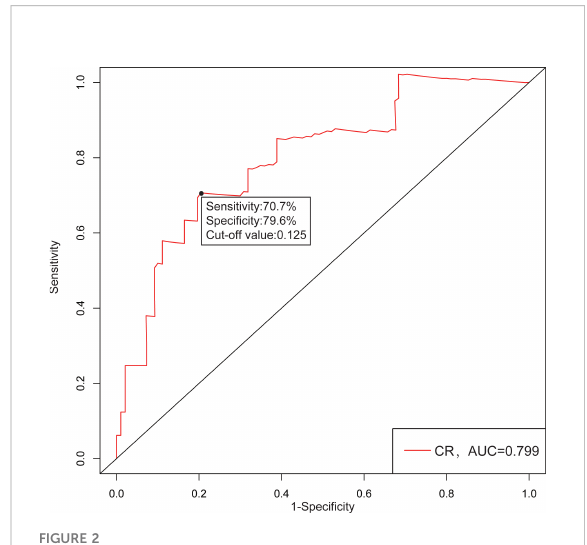
FIGURE 2 The receiver operating characteristic (ROC) analysis for CR cut-